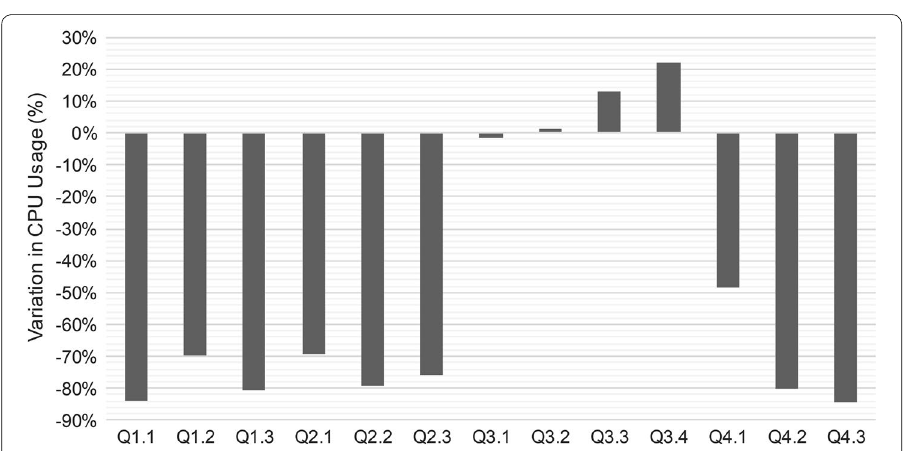
Fig. 7 CPU usage: bucketing by “Od_Year” and Sorted by “P_Brand” (Presto, SF